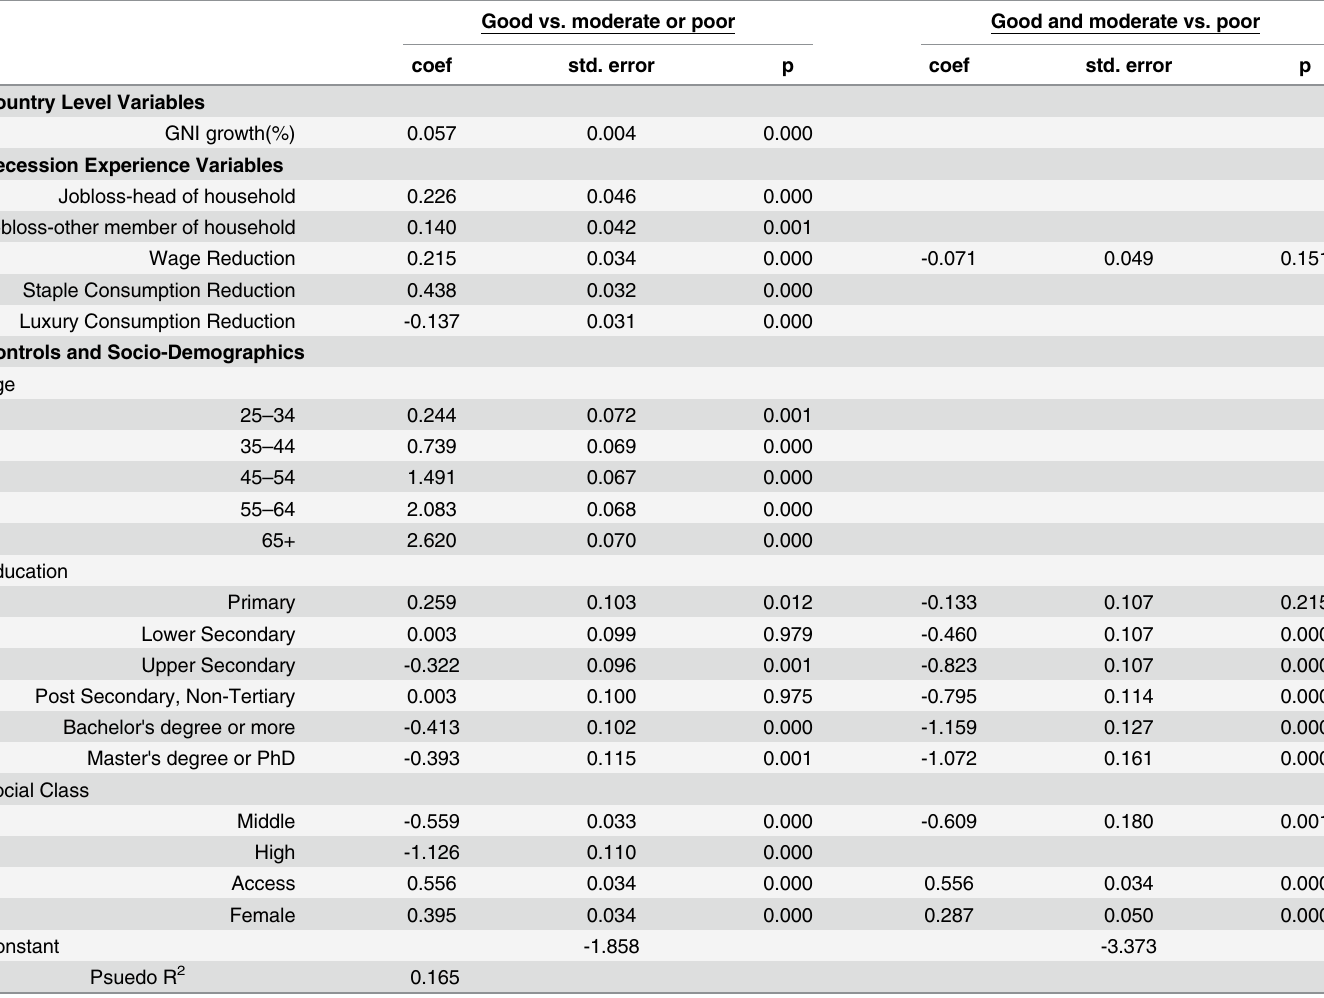
Table 5. Weighted Partial Proportional Odds Model of Self-Rated Health, all